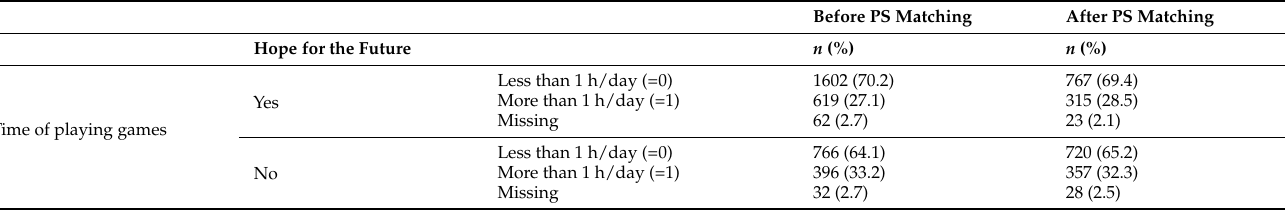
Table 2. Distribution of answers about time usage before and after propensity score